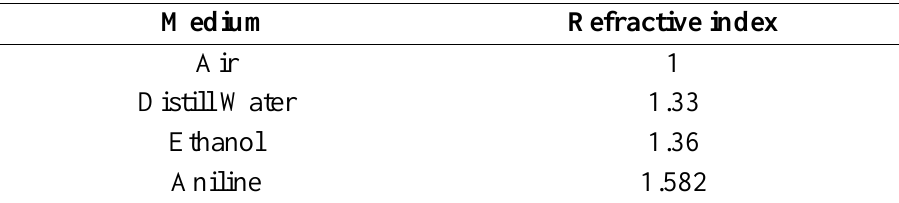
Figure 4. SEM image of immobilized Au coating on the tip of the fiber Table 1. Refractive index